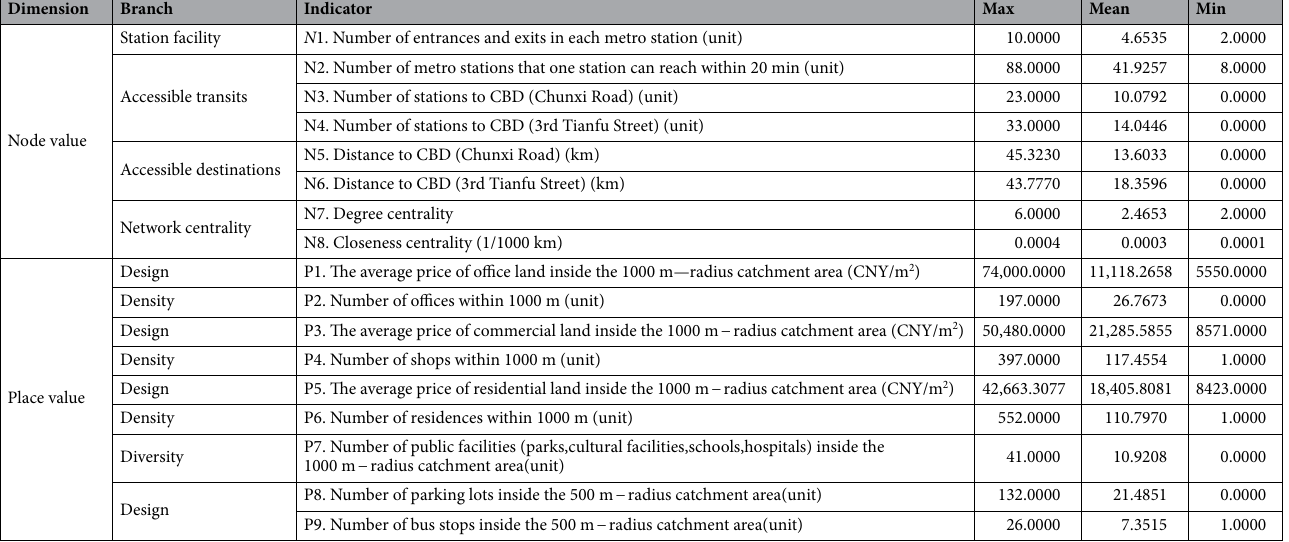
Table 3. Node and place indicators.